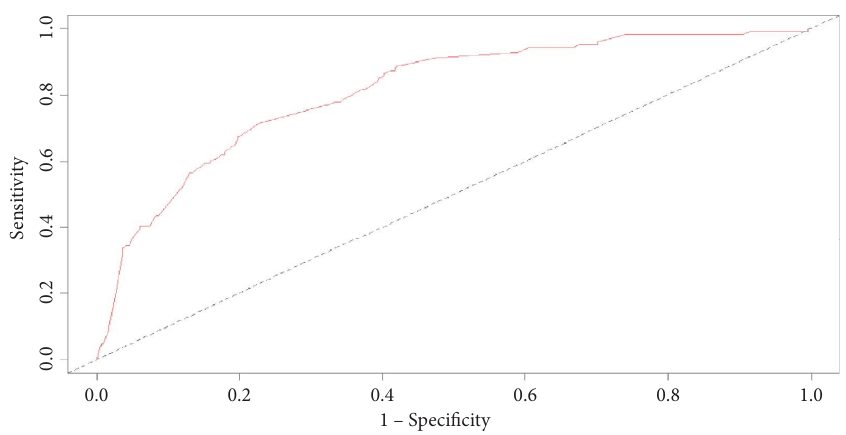
Figure 3: ROC curve of the prediction model in the validation